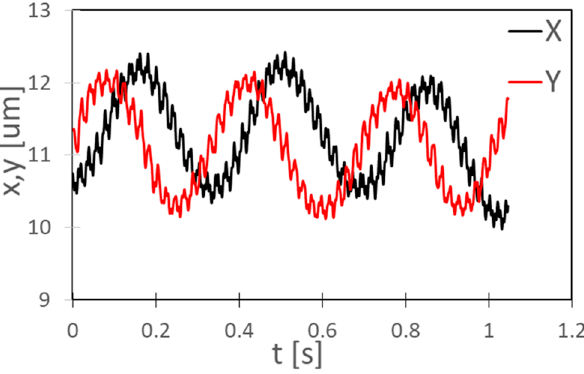
Figure 12. Displacement of the center of a C. reinhardtii during three rotations.